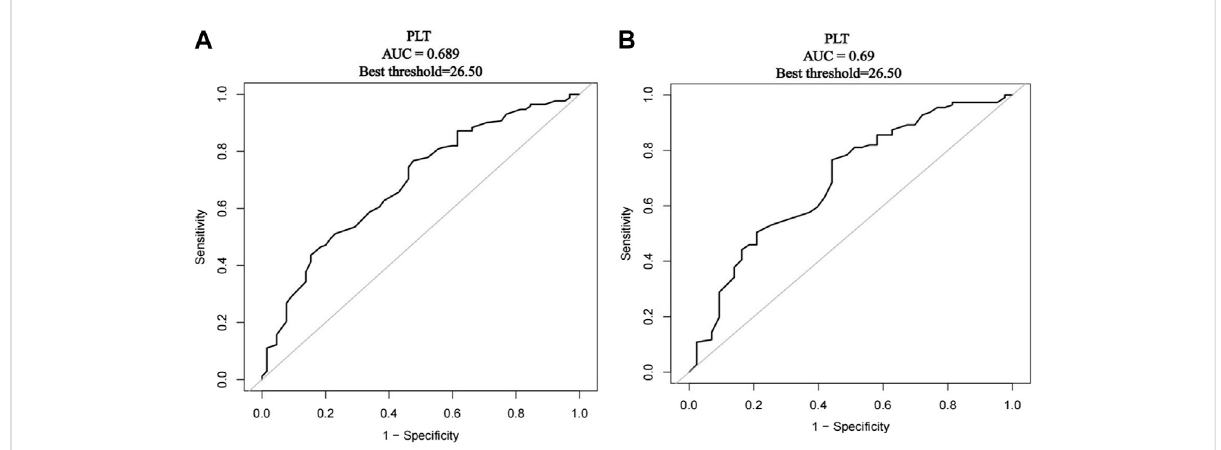
FIGURE 3 Receiveroperatingcharacteristics(ROC) curveofplateletcount diagnosedwithoutcomeindicators. (A) Before PSM,theROC diagnostic curve of platelet count diagnosed with outcome indicators. (B) After PSM, the ROC diagnostic curve of platelet count diagnosed with outcome indicators.